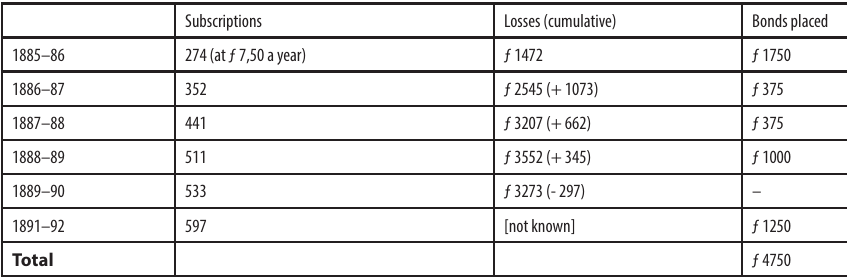
Table 1 Financial overview for De nieuwe gids